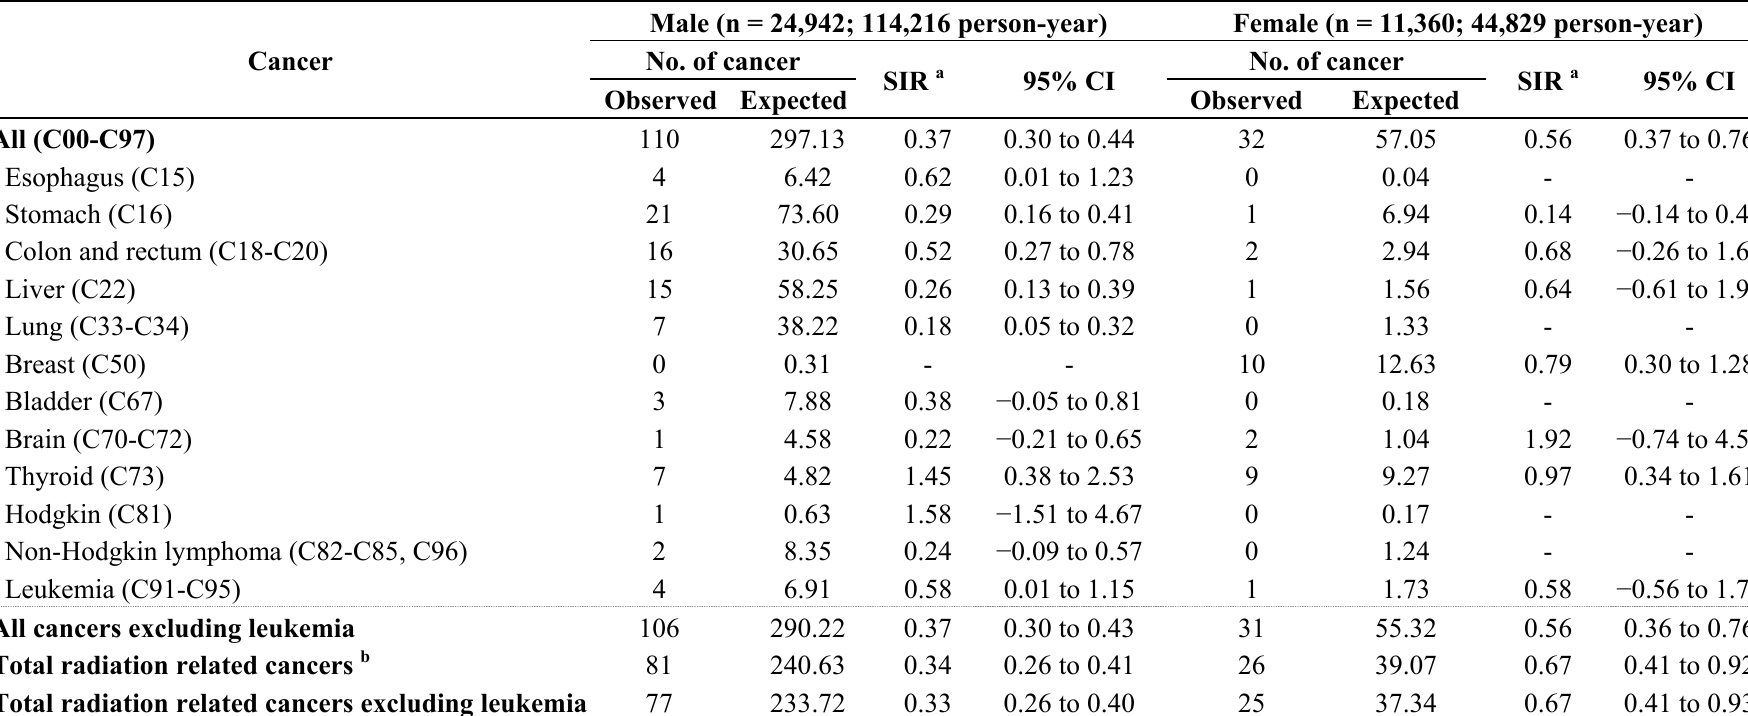
Table 2. Standardized incidence ratio (SIR) by gender in diagnostic radiation workers, Korea,